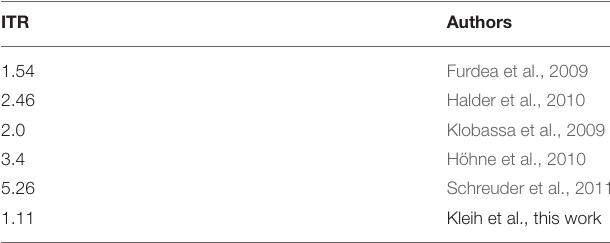
TABLE 5 | ITRs achieved in auditory paradigms and the corresponding